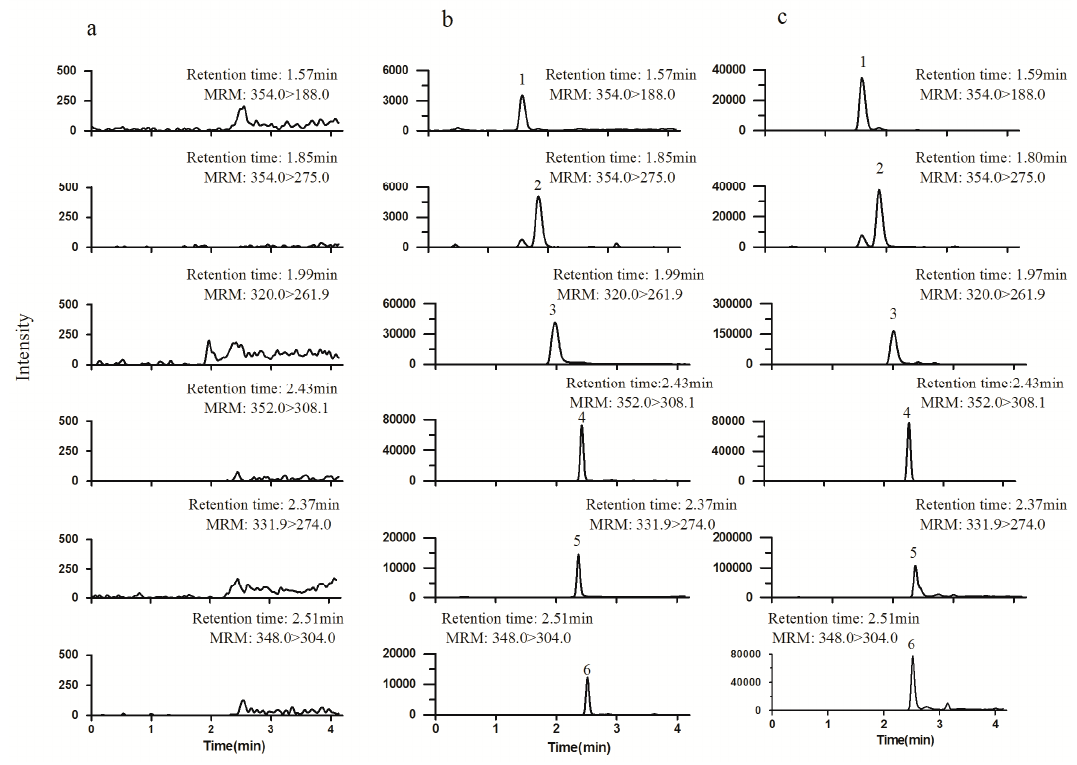
Figure 1. Representative multiple reaction monitoring (MRM) chromatograms of blank cell lysates ( a ), blank cell lysates spiked with standard solutions ( b ), and cell lysates collected after coincubation with Chelidonium majus for 10 min ( c ). Peak 1: protopine; 2: chelidonine; 3: coptisine; 4: palmatine (internal standard, IS); 5 sanguinarine; 6: chelerythrine.